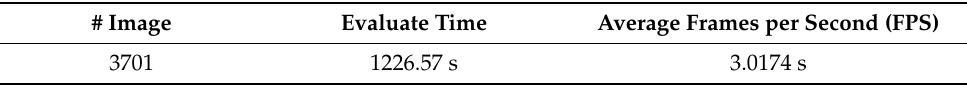
Table 6. Performance efficiency of the LDCNN model on Raspberry Pi